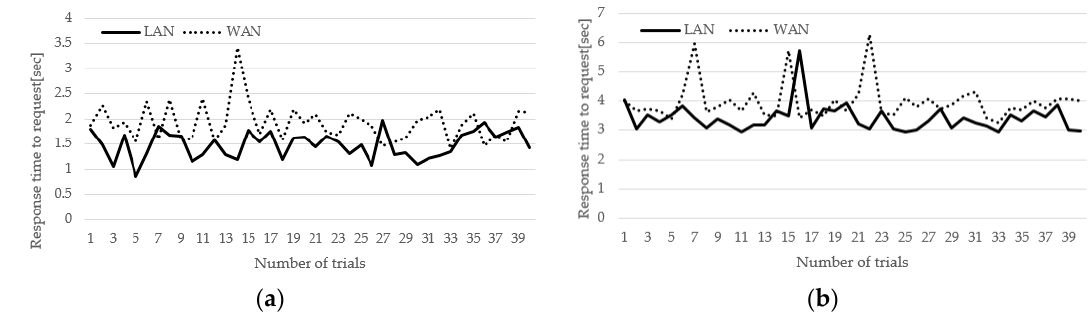
Figure 16. Experiment environment of service start time according to streaming request. ( a ) Without lookup neighbors; ( b ) Lookup neighbors. Figure 17. Response time to streaming request of LAN and WAN environment. ( a ) Without lookup neighbors; ( b ) Lookup neighbors.